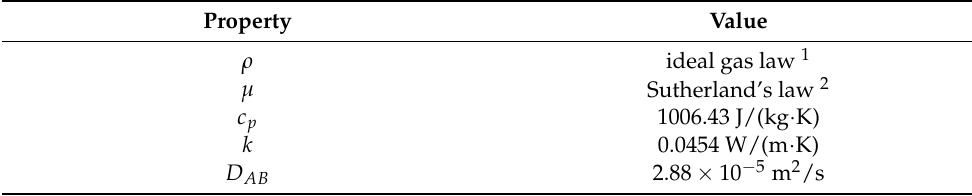
Table 2. Material properties.